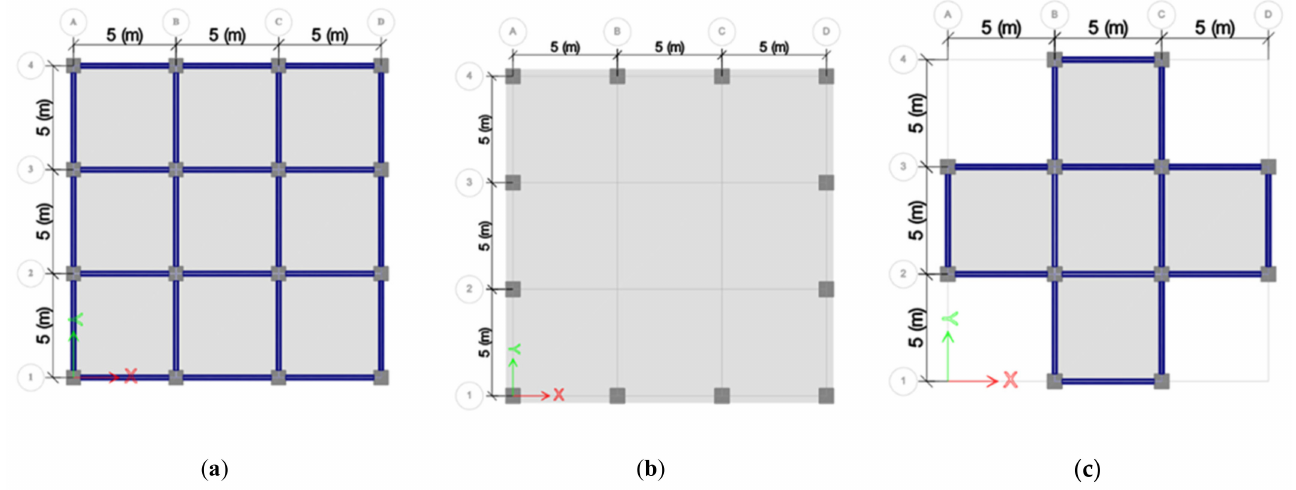
Figure 6. Plan views of the combined irregularity models: ( a ) regular slab; ( b ) transfer slab; ( c ) slab with setback.